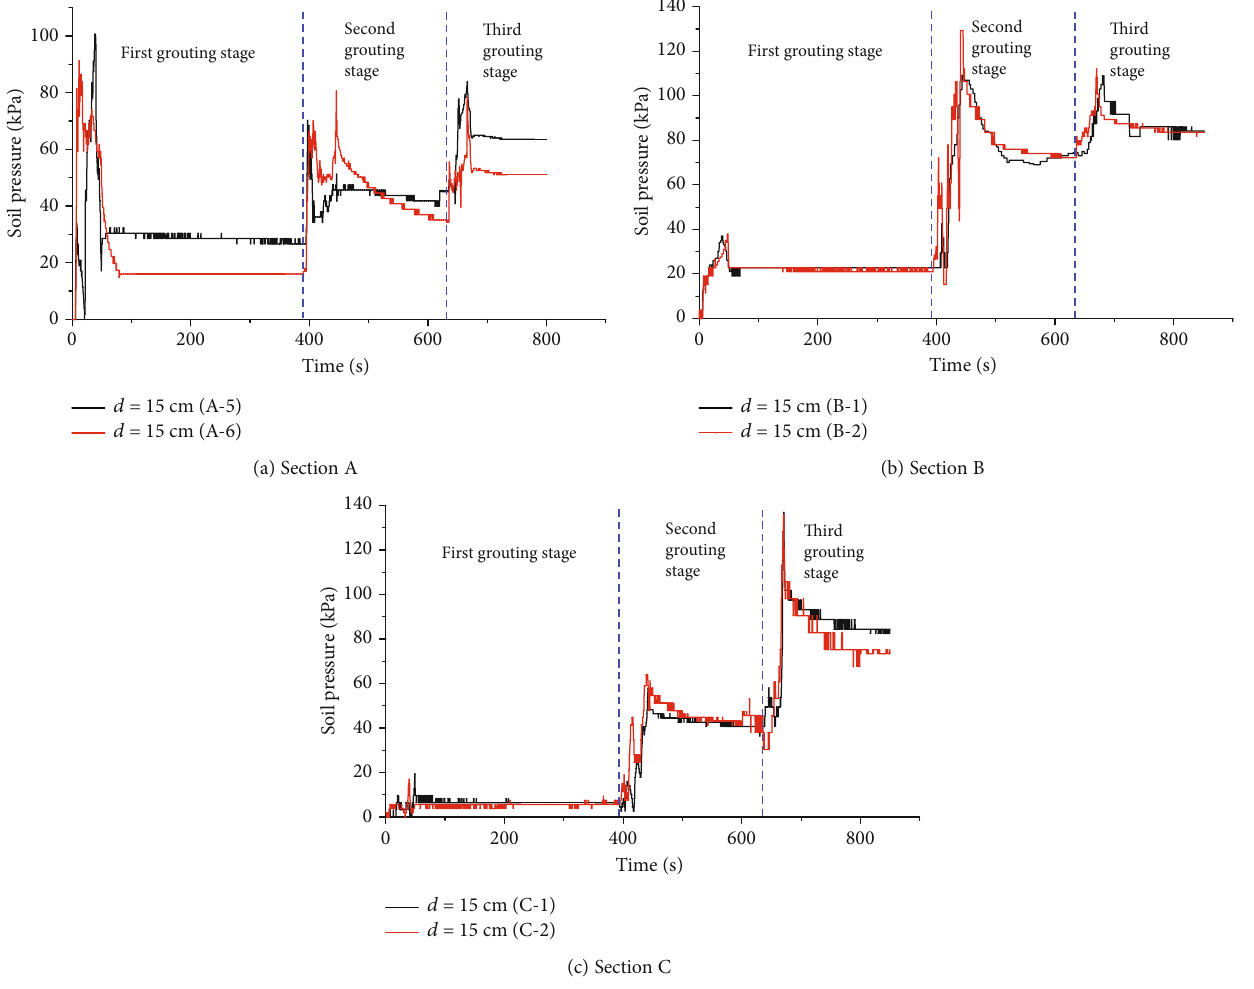
Figure 11: Variation of soil pressure with time in three grouting stages.